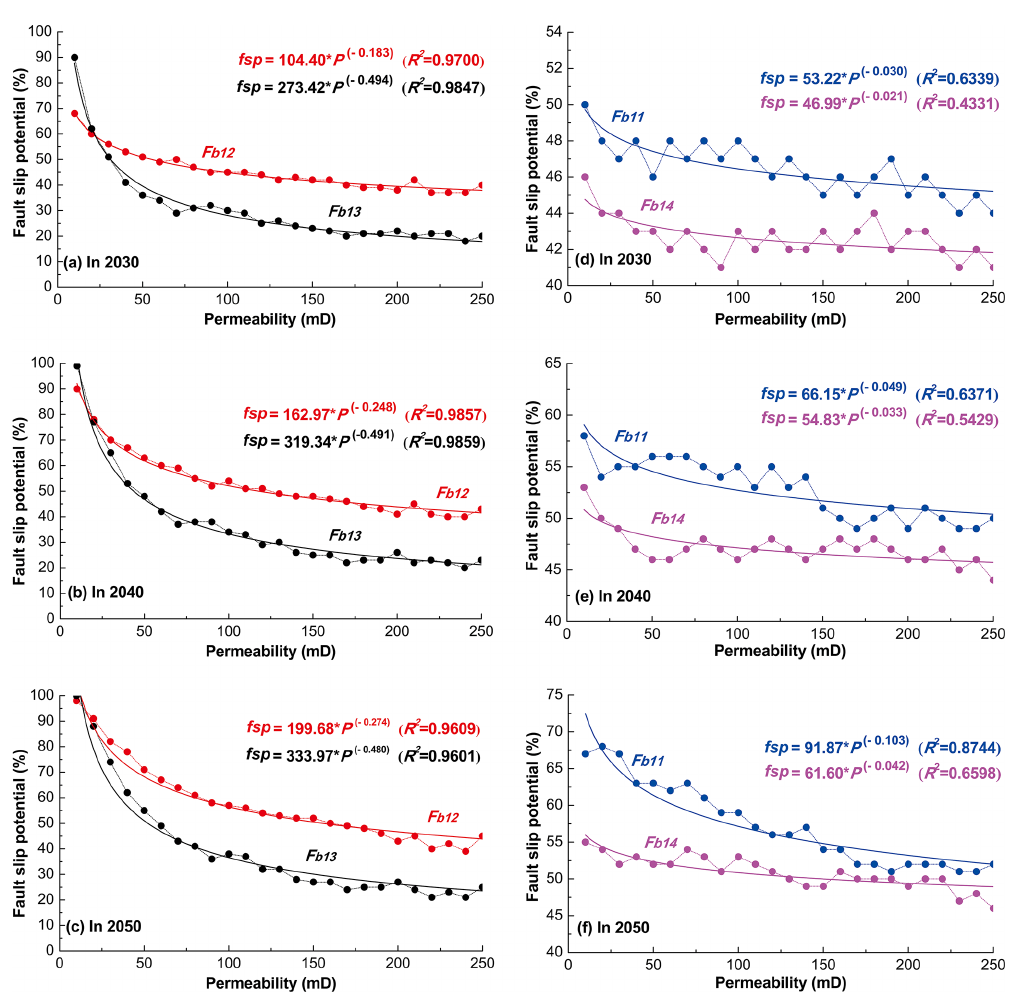
Figure 14. The effect of permeability on probabilistic fault slip potential on the mapped faults F b11 , F b12 , F b12 , and F b14 , within a range of ∼ 6–10km away from the MTY EGS